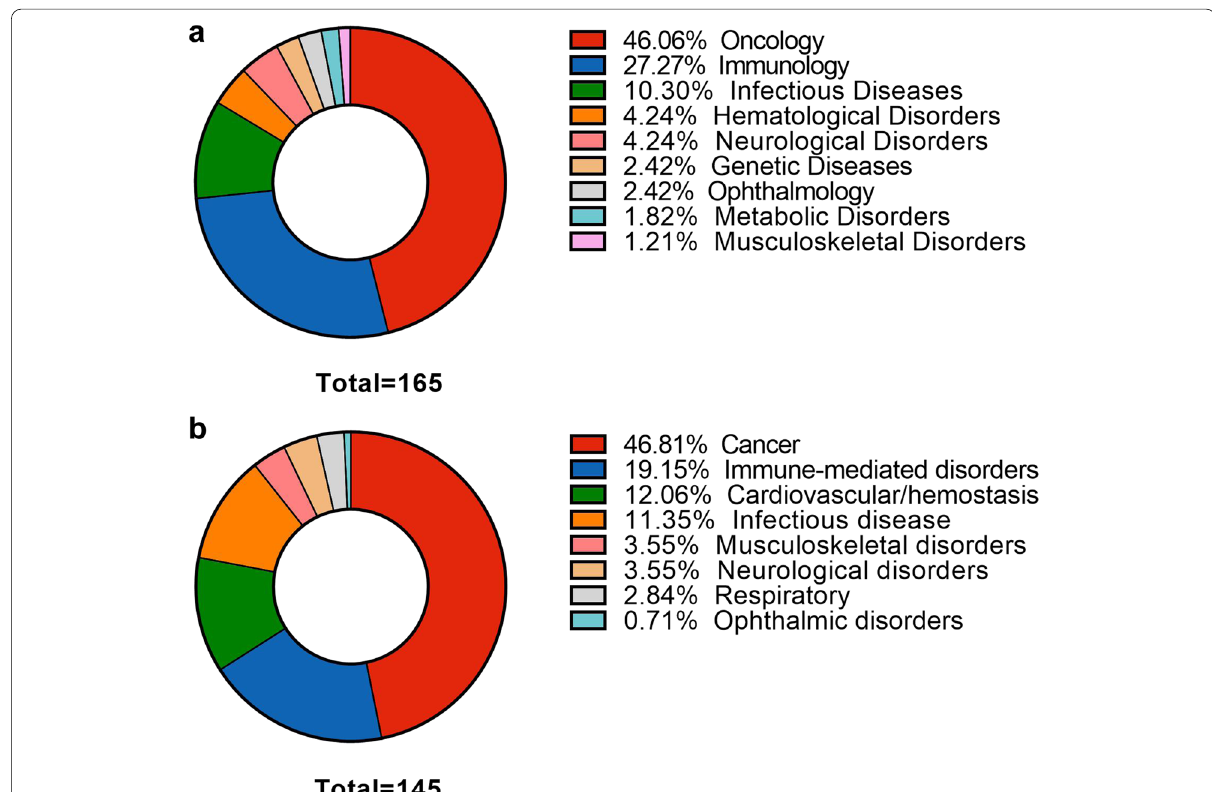
Fig. 1 Primary indications for antibody therapeutics are approved across the globe and in late-stage clinical studies sponsored by commercial firms. a Primary indications for antibody therapeutics are approved across the globe. Immune-mediated disorders category includes asthma, systemic lupus erythematosus, rheumatoid arthritis, etc.; the genetic disorders are Muckle-Wells syndrome, X-linked hypophosphatemia, hereditary angioedema attacks, and homozygous familial hypercholesterolemia. Figure based on data publicly available (www. antib odyso ciety. org/ antib ody- thera peuti cs- produ ct- data/.) as of July 1, 2022, total 165. b Primary indications for antibody therapeutics in late-stage clinical studies. = “Late-stage” is defined as pivotal Phase II, Phase II/III, or Phase III studies. Immune-mediated disorders category includes allergy and asthma; respiratory includes chronic obstructive pulmonary disease. Figure based on data publicly available (www. antib odyso ciety. org/ antib ody- thera peuti cs- produ ct- data/.) as of May 1, 2022, total =